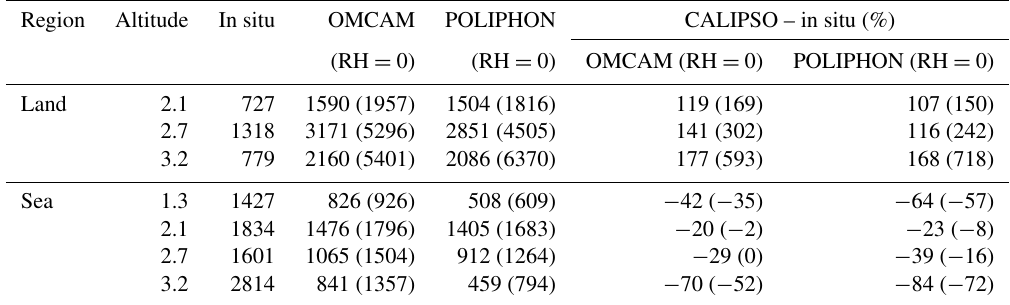
Table 4. The n 50,dry concentrations (in cm − 3 ) from in situ measurements (Tsekeri et al., 2017) and CALIPSO measurements by using OMCAM and POLIPHON (Georgoulias et al., 2020) algorithms at different altitudes over land and sea regions around Thessaloniki, Greece. The values inside the brackets refers to zero-humidity case (no hygroscopicity correction applied). Region Altitude In situ OMCAM POLIPHON CALIPSO – in situ (%) (RH = 0) (RH = 0) OMCAM (RH =